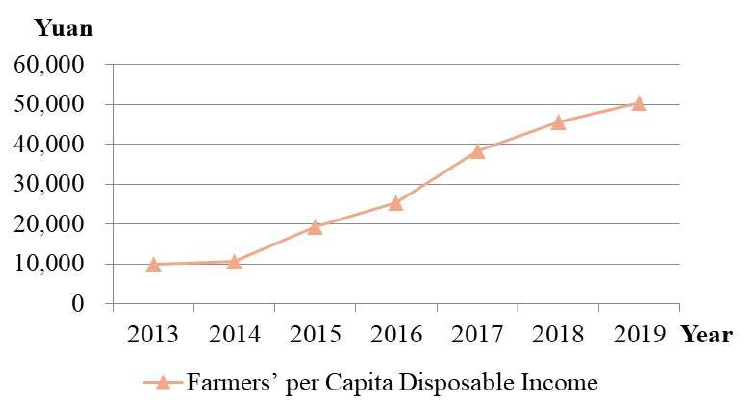
Figure 11. Farmers’ per capita disposable income in Baiyankeng village (2013–2019) (data provided by the village